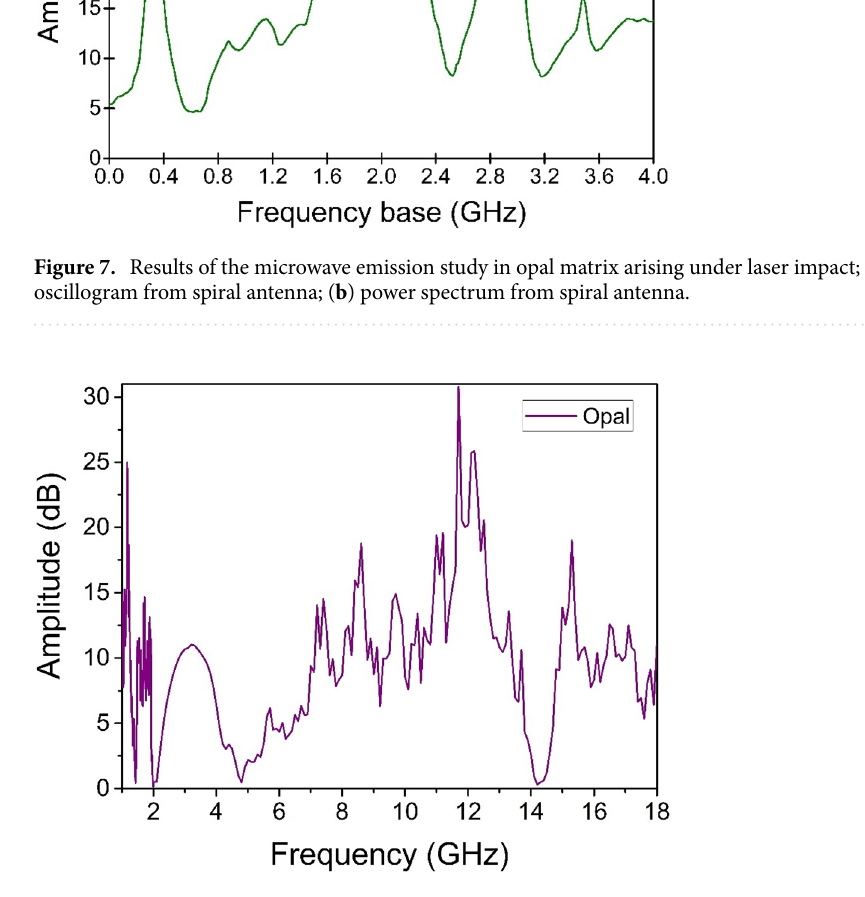
Figure 8. Typical EM emission power spectra registered by a wideband horn